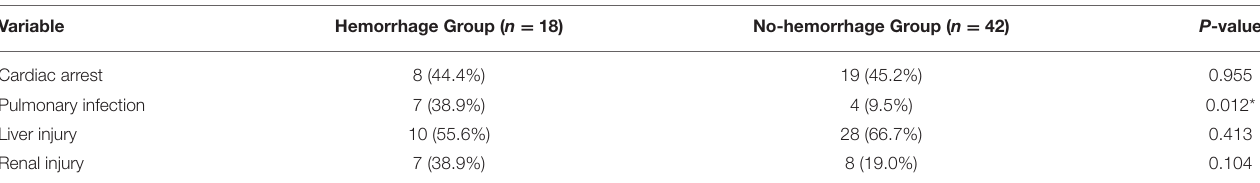
TABLE 2 | Hemorrhage-related organ function before the ECMO initiation.